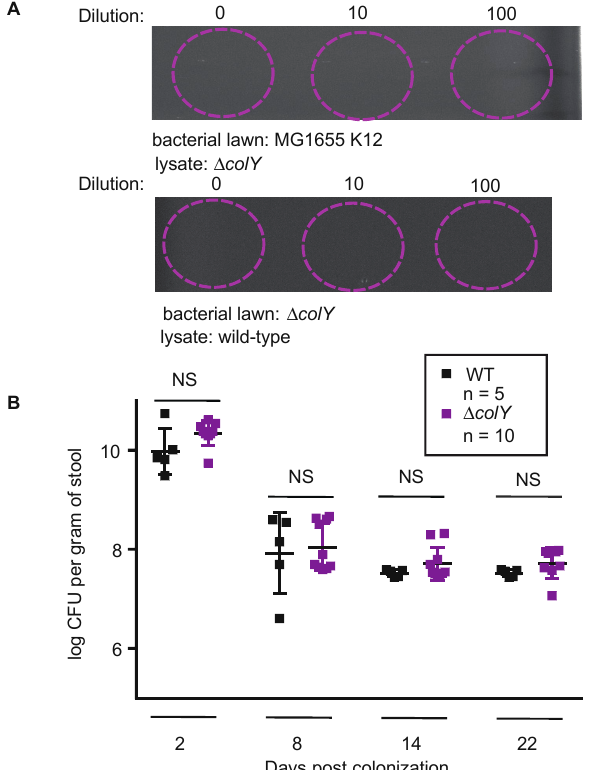
Figure 2. Colicin-deficient strain can establish colonization in healthy mouse gastrointestinal tract. ( A ) Shown is the inhibition halo of ∆ colY strain exposed to 50 J / m 2 and extracted lysate spot plated on a lawn of E. coli MG1655-K12 and inhibition halo of wild-type strain exposed to 50 J / m 2 and extracted lysate spot plated on a lawn of ∆ colY strain. Dilutions of cell lysates were made and indicated. Circles indicate location of spotted lysate. ( B ) Groups of 6- to 8-week-old C57BL / 6 male mice were orally inoculated with either the wild-type strain (black squares) or the ∆ colY strain (purple squares). On the days indicated, fecal samples were collected and CFU counts were determined. Each square represents one mouse and the limit of detection was 10 3 . Significant p values are noted (NS, not significant) and were calculated using a two-tailed unpaired Student’s t test. If colonies were too numerous to count on a plate, the corresponding animal was excluded from the data on that day.